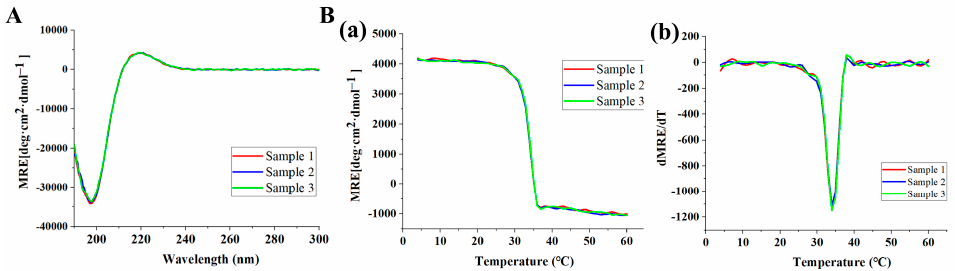
Figure 1. CD spectrum of THRC samples from different batches (sample 1, sample 2, and sample 3). ( A ) CD thermal transition curves; ( B ) CD thermal unfolding curves ( a ) and the first derivative of the thermal unfolding curves ( b ).